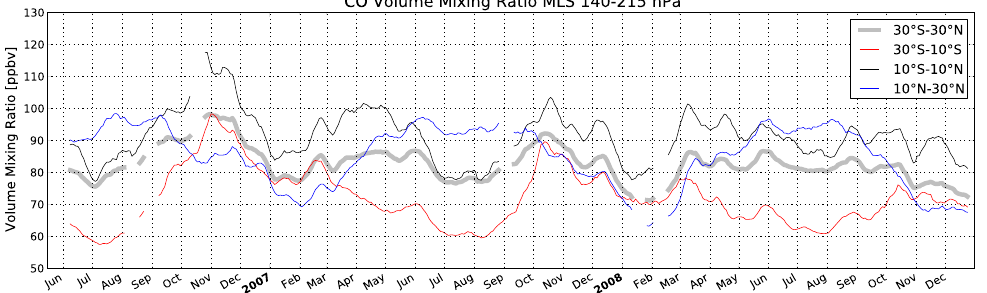
Fig. 14. Daily CO volume mixing ratios observed by MLS (Level 2 CO product v.3) between 140 and 215hPa, averaged using a 15-days moving window over the same latitude bands as in Fig.